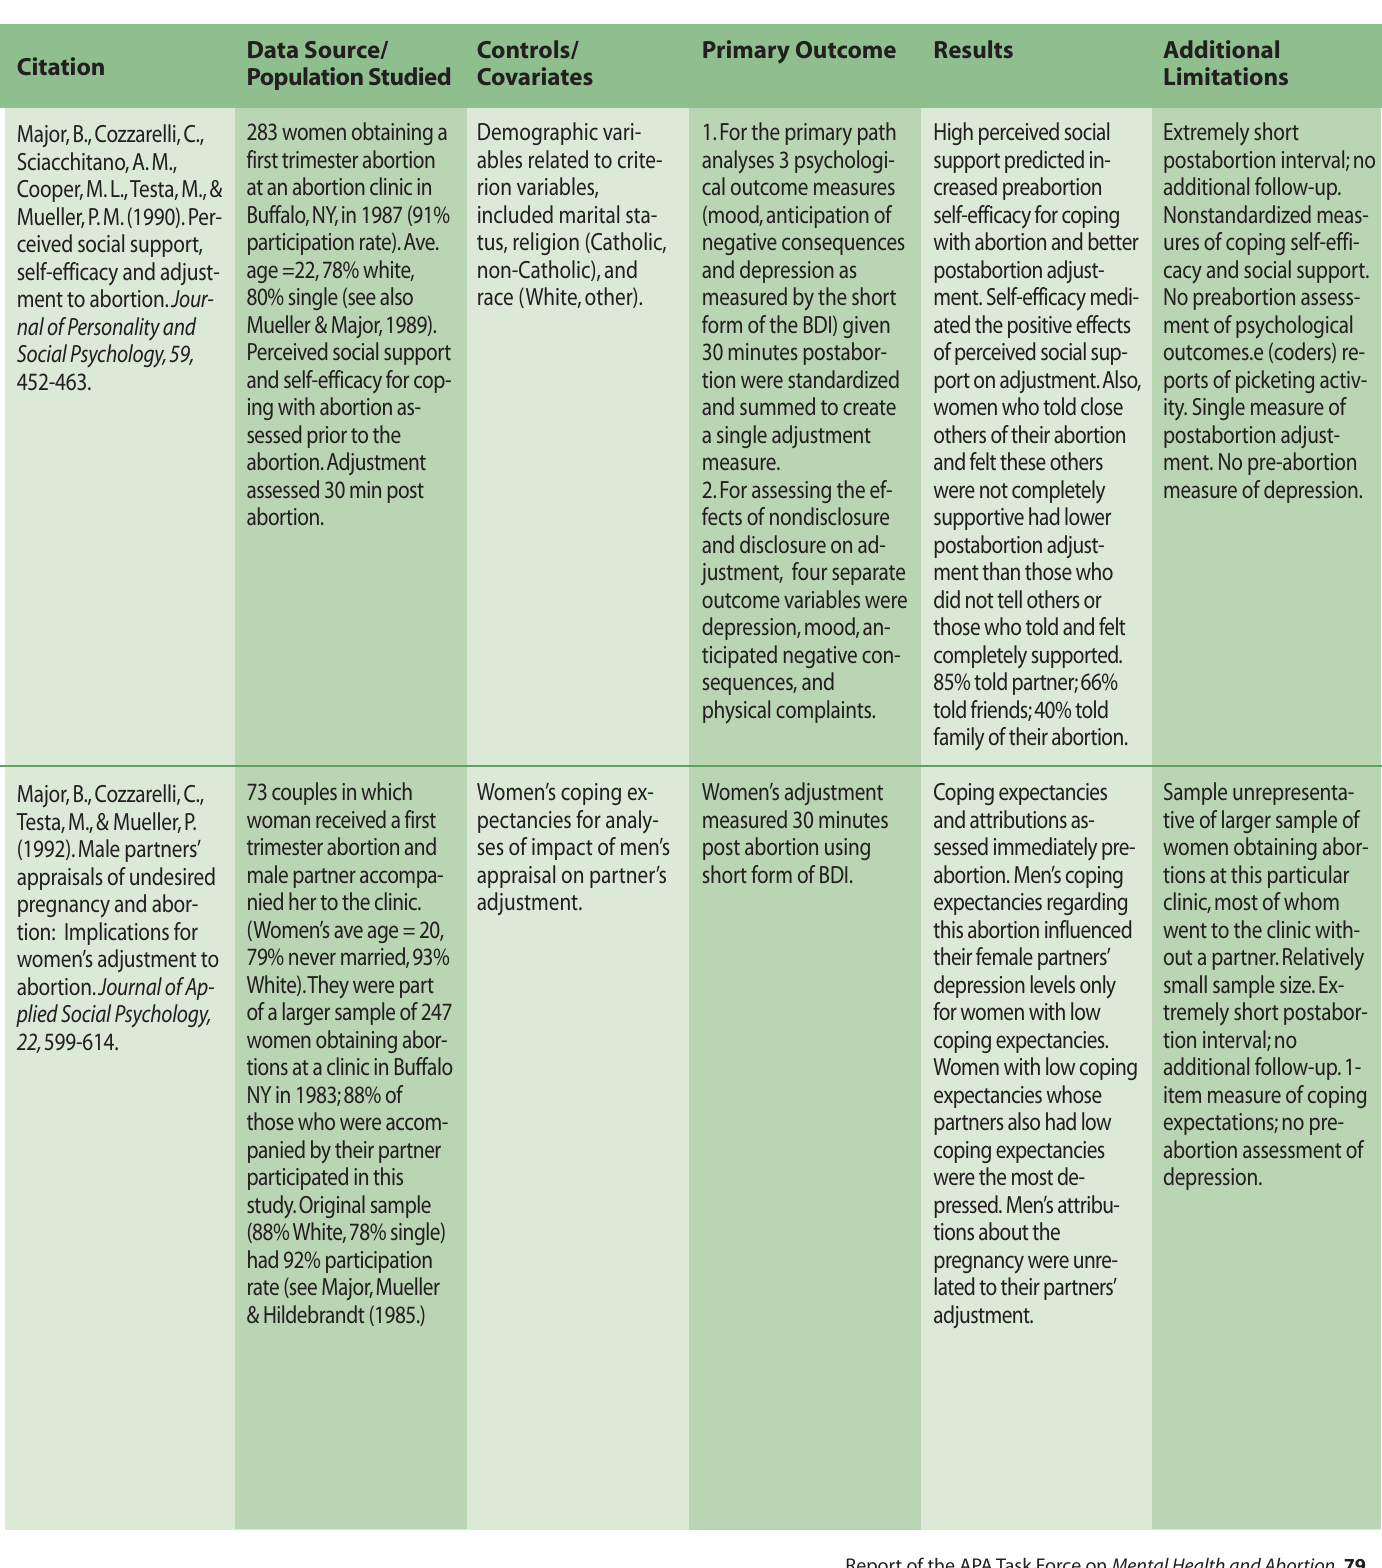
Table 5: U.S.Samples of Abortion Group(s) Only/No Comparison (continued) Other Prospective